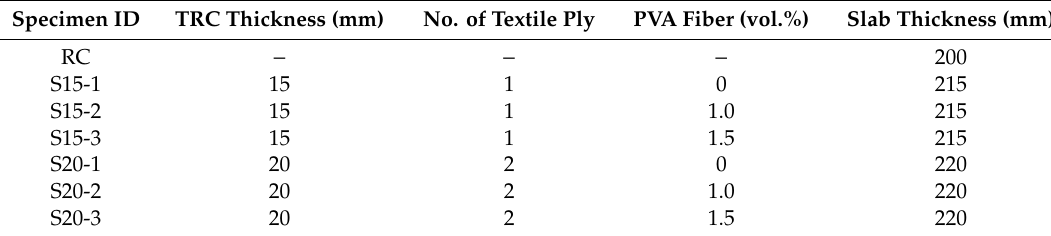
Figure 4. Dimensions of a full-scale slab specimen. ( a ) Cross-sectional view; ( b ) Plan view (units: mm). Table 5. Dimensions of full-scale slab specimens.